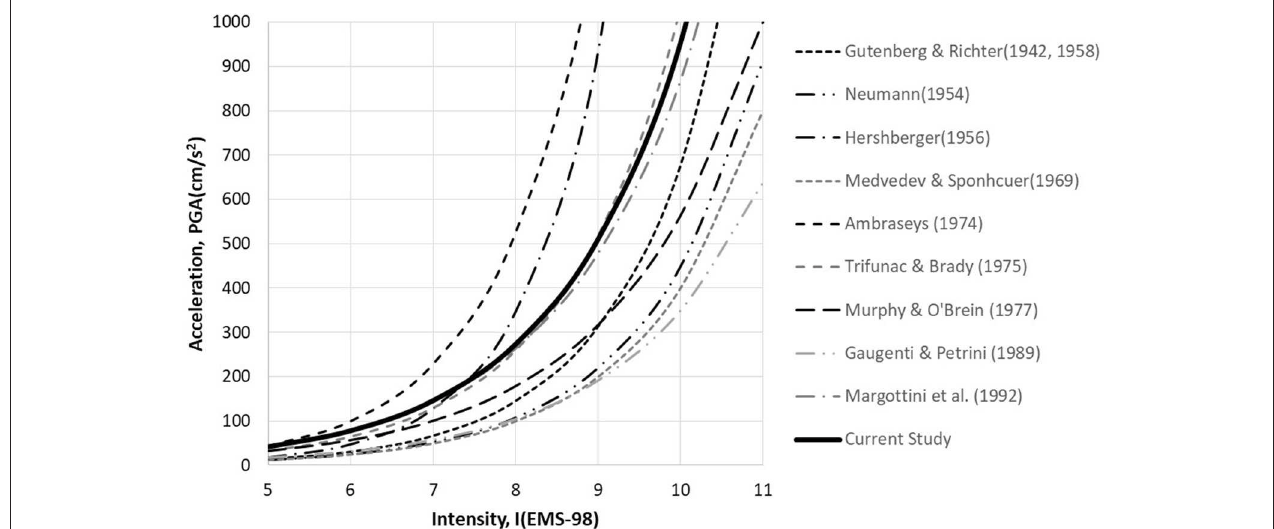
FIGURE 4 | Relationships proposed for PGA/I